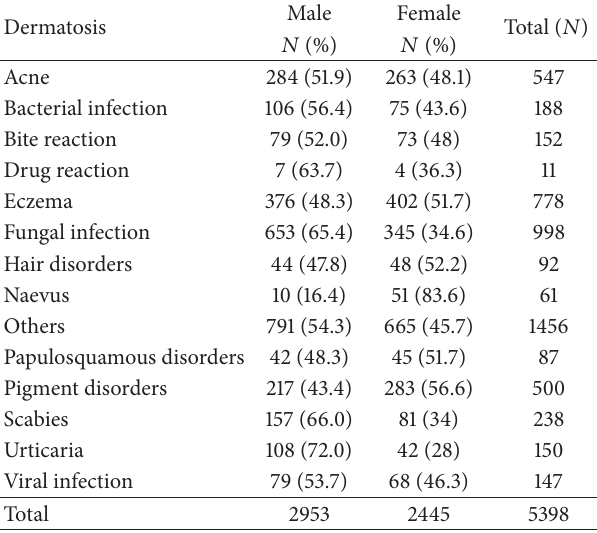
Table 2: Gender distribution of different dermatoses. Dermatosis